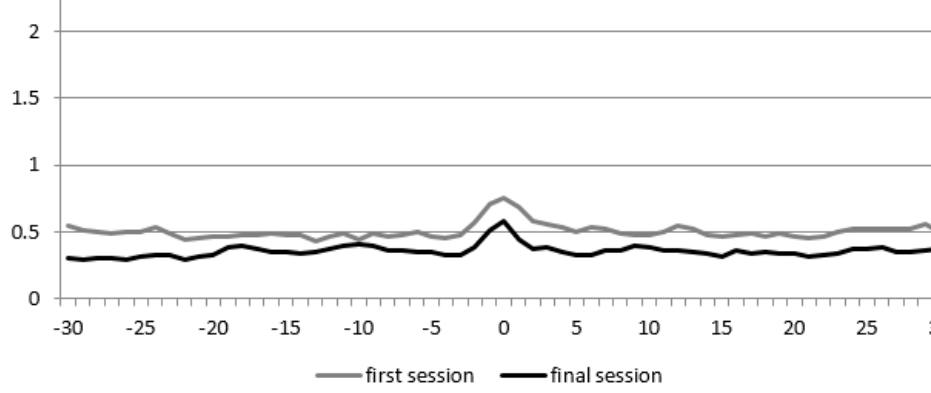
Figure 5. Diagonal Cross-Recurrence Profile (DCRP) of participant 4. The X-axis displays the delay in 0.5 s, and the Y-axis the recurrence rate (the proportion of accurate